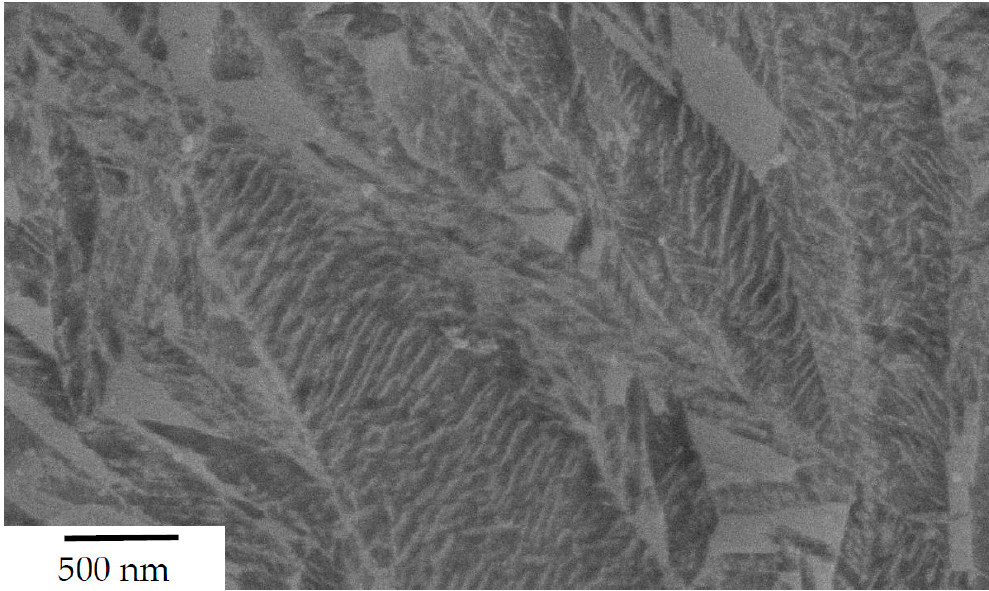
Figure 3. FESEM micrograph of steel A0 after heat treatment acc. to route ① .